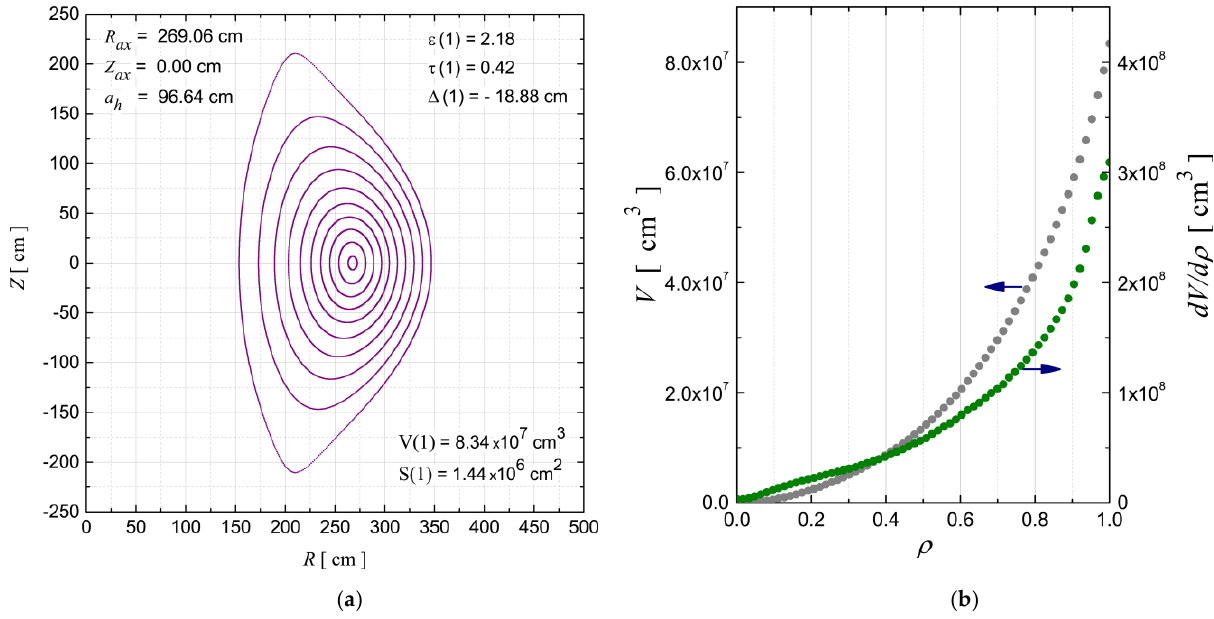
Figure 5. (a) Isolines of the effective radius in the poloidal plane; (b) Volume (left scale) enclosed by a magnetic surface versus the normalised poloidal radius and the derivative of the volume (right scale) calculated for a candidate regime of DEMO-FNS.